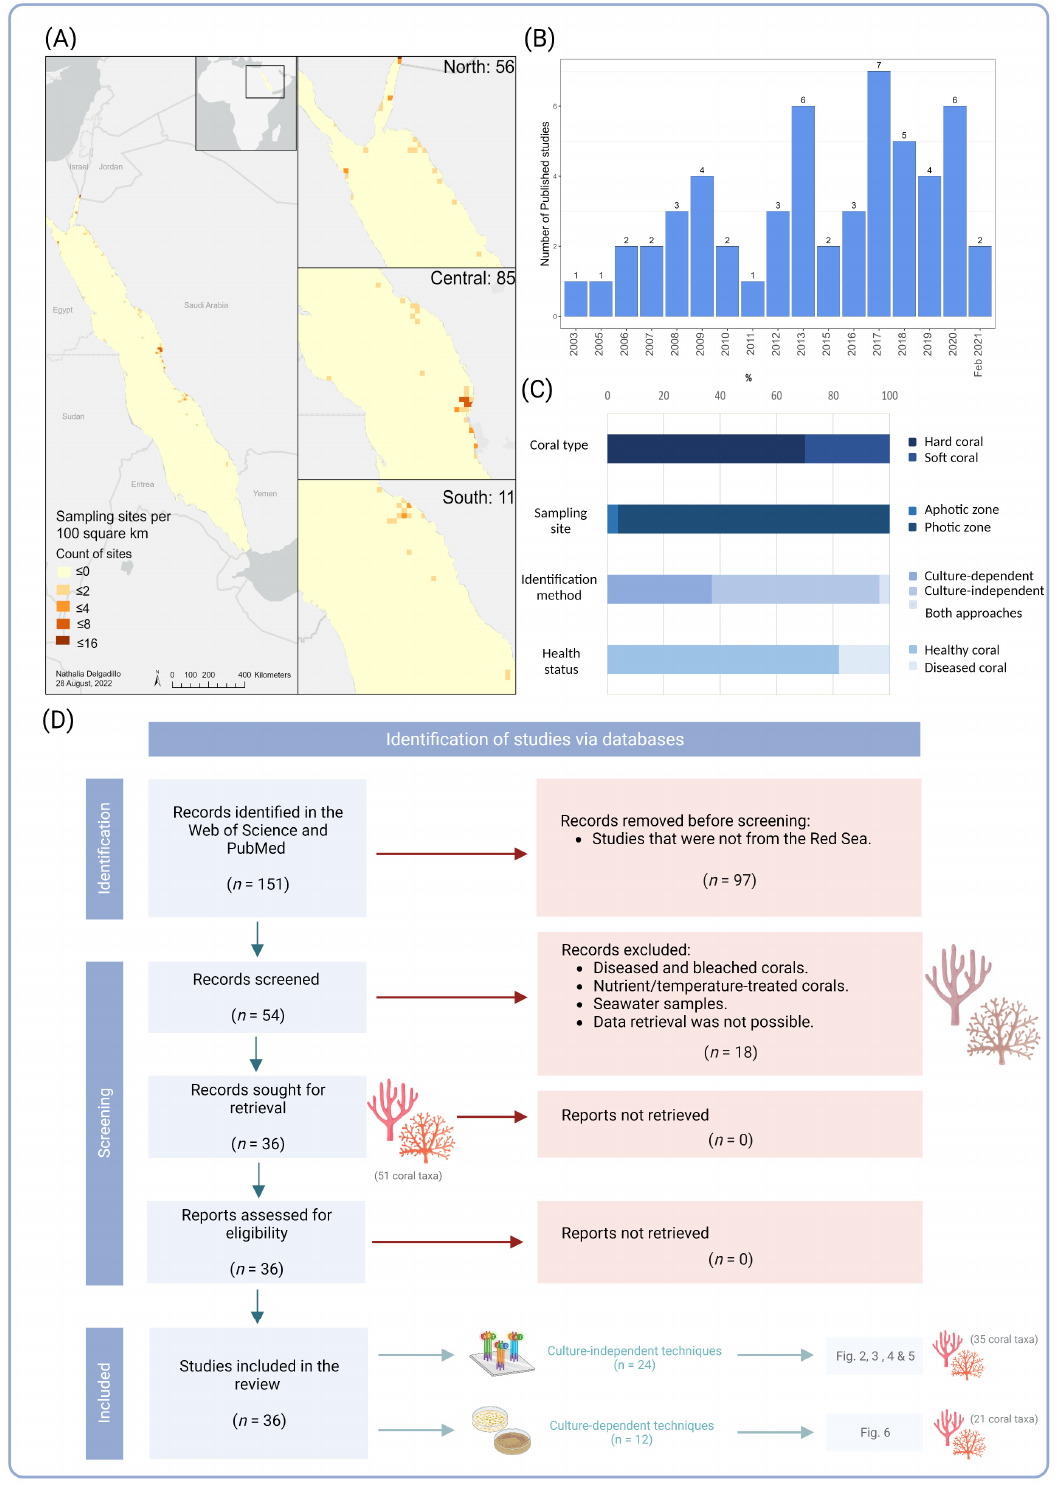
Figure 1. Systematic review of published studies investigating bacterial communities associated with corals along the Red Sea using a literature survey in the PubMed and Web of Science databases. ( A )